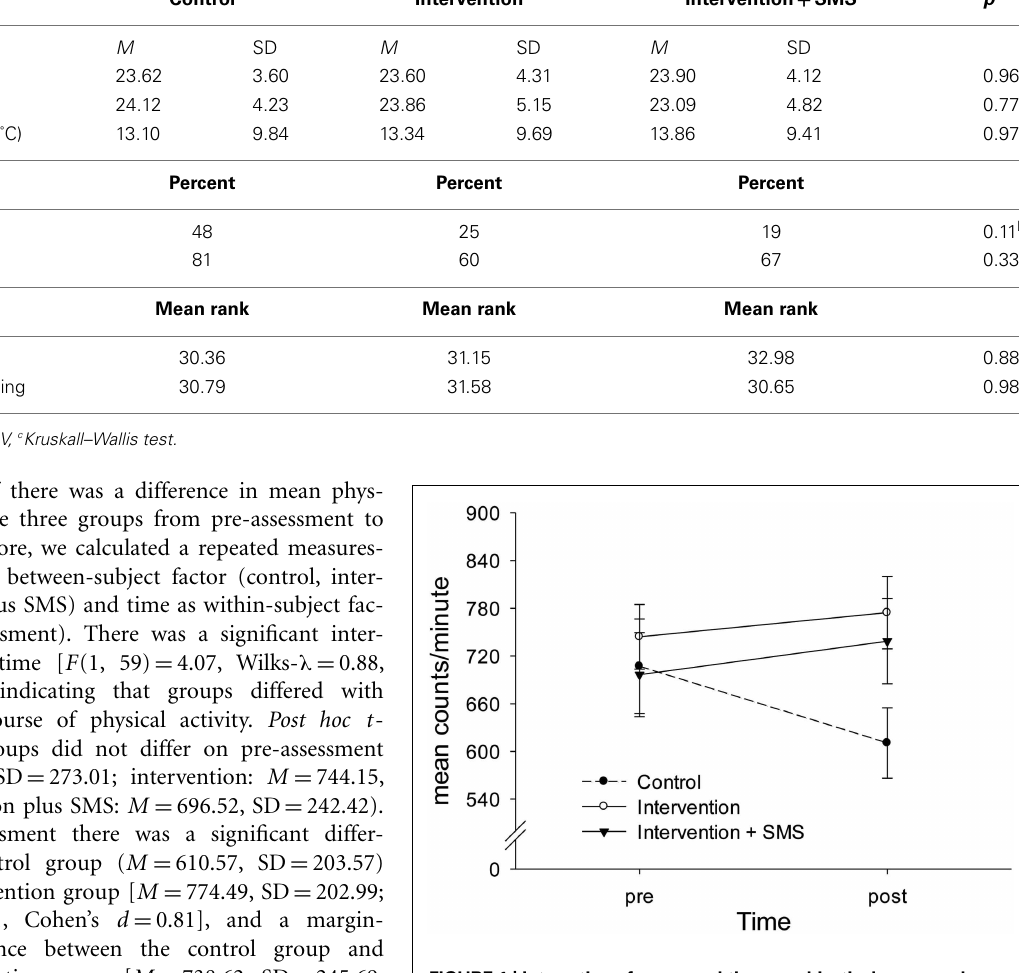
FIGURE 1 | Interaction of group and time on objectively assessed physical activity. The control group showed a significant decline in physical activity from pre- (week 1) to post-assessment (week 2), whereas both intervention groups increased their levels of physical activity moderately. There was no significant difference between the standard intervention and the augmented intervention group (with text messages).Whiskers indicate ± 1 standard